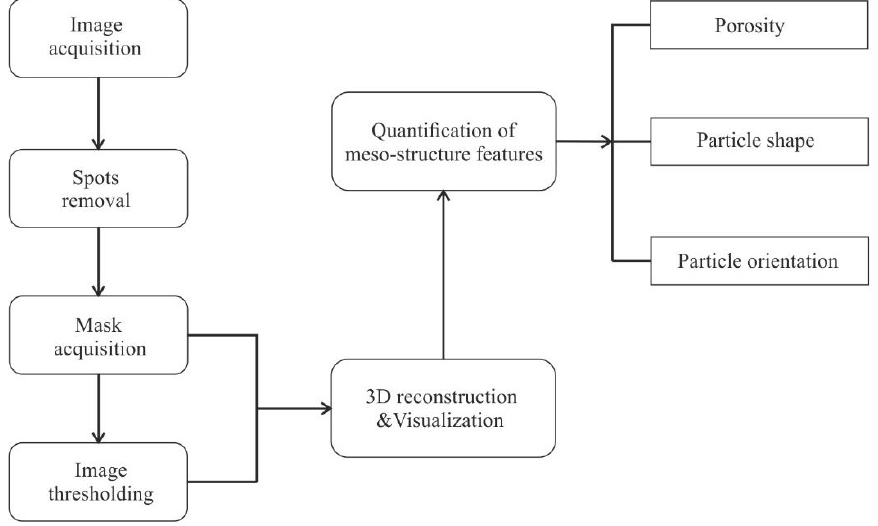
Table 1. Physical parameters of soil in cyclic freeze–thaw test. Figure 6. Processing flow of CT scan image. Figure 6. Processing flow of CT scan image.